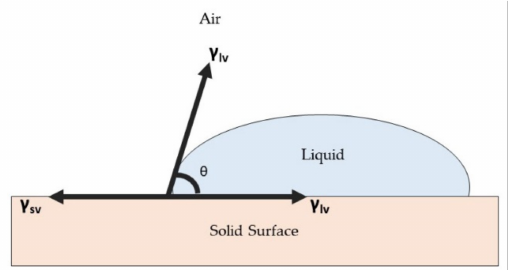
Figure 8. Three different interfacial boundaries’ contact line for water contact